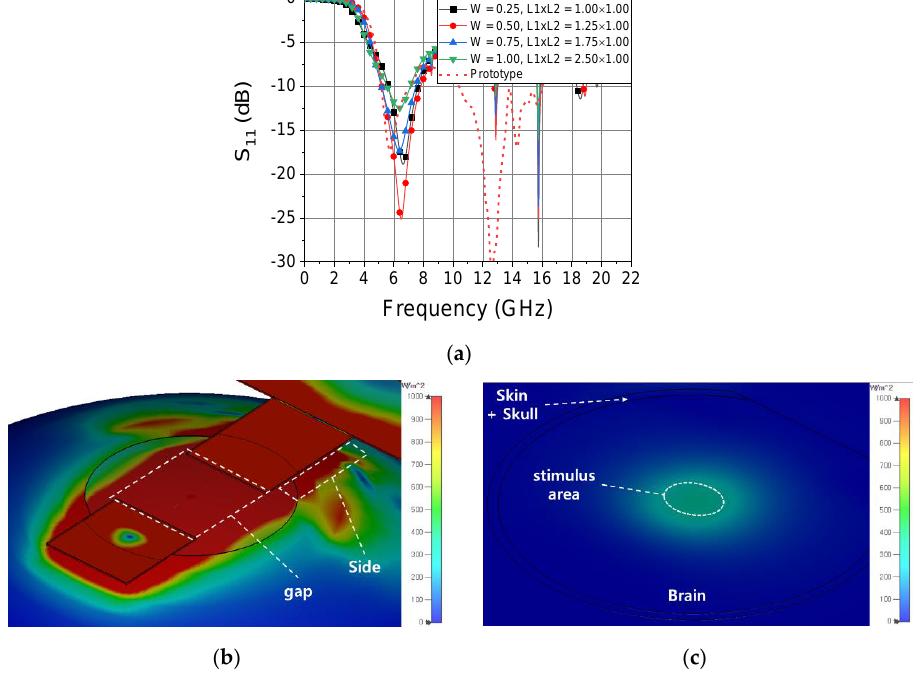
Figure 7. Simulated ( a ) S11 of the probe in contact with the brain for a differently sized matching loop with resonance of 6.5 GHz ( b ) power distribution at the surface of the brain model in contact with the probe and ( c ) within a depth of 3 mm. Table 1. Geometric parameters, insertion losses, and impedance bandwidths of the modified SRR for 6.5 GHz brain-to-probe matching.